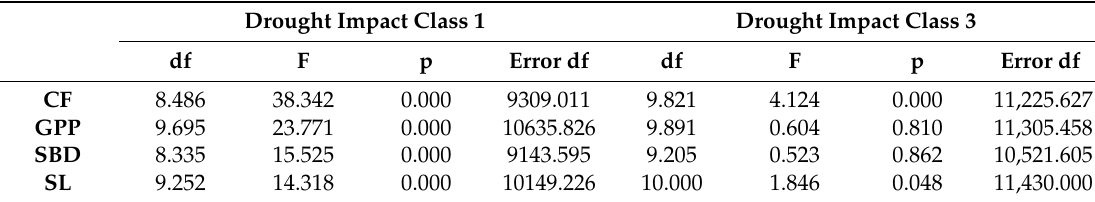
Table A4. Significance of differences in 2002–2012 annual forest phenology and green biomass production as indicated by repeated measure ANOVA models inspected separately for drought impact class 1 and 3 of the 3nNDVI PC. Abbreviations correspond with Table A1.